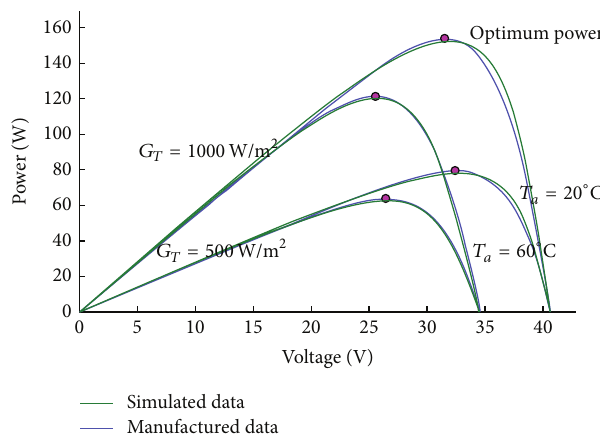
Figure 9: P-V characteristic curve at various set of solar radiation and